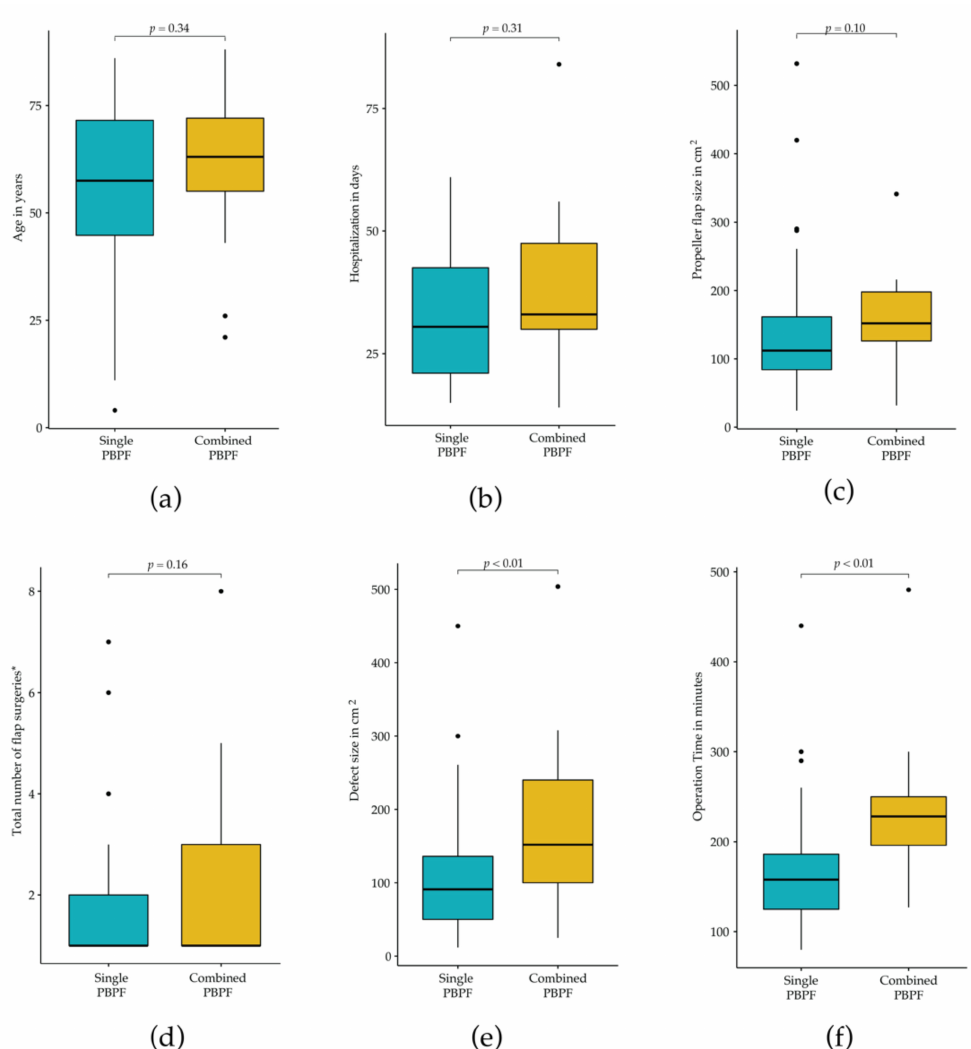
Figure 2. Wilcoxon–Mann–Whitney test on continuous variables. ( a ) Age in years; ( b ) Total hospital- ization in days; ( c ) Perforator propeller flap size in cm 2 ; ( d ) Total number of surgeries starting with PPF surgery; ( e ) Defect size in cm 2 ; ( f ) Operation time in minutes (Abbreviations: PPF, perforator propeller